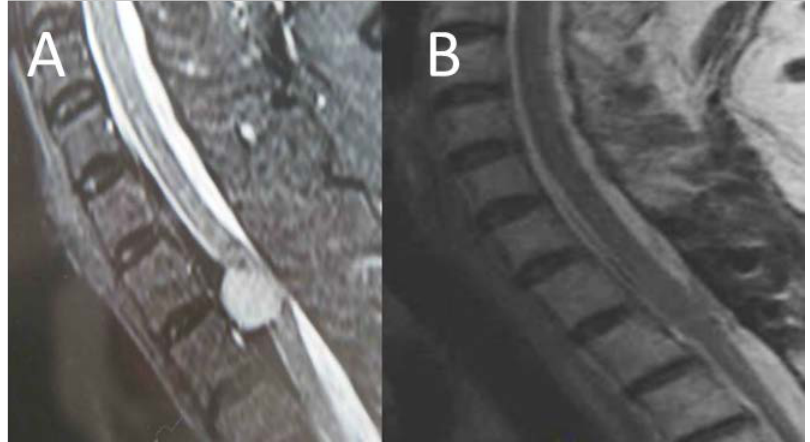
Figure 2.A - Patient with spinal cord compression due to one anterior tumor. B -Postoperative MRI from case 2. Complete tumor